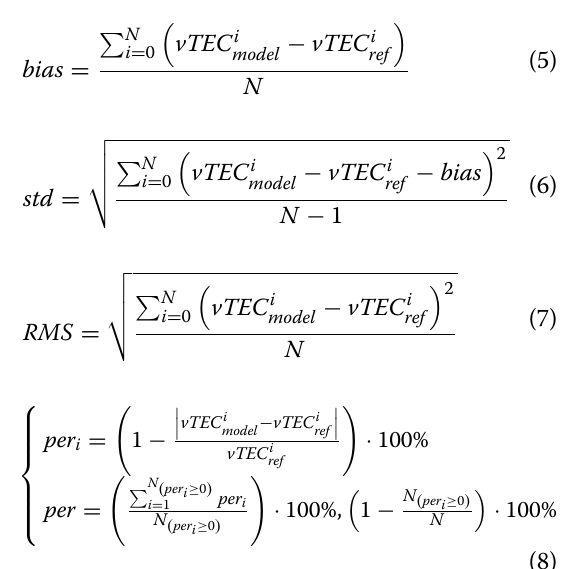
The accuracy of broadcast clock offset in the evaluation